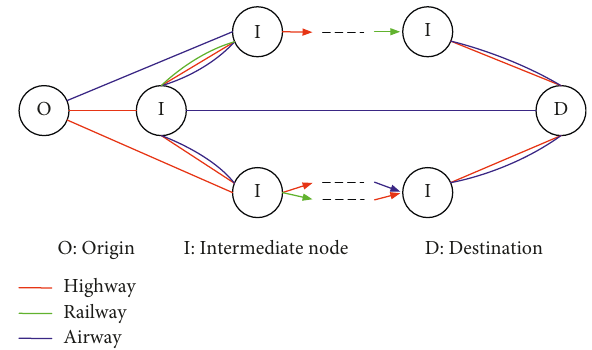
Figure 2: Multimodal transport network diagram.